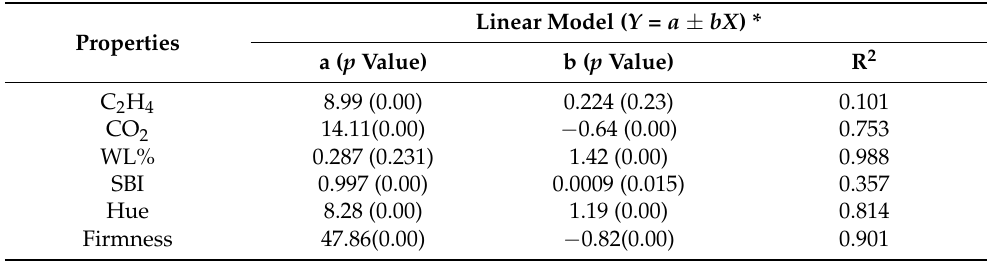
Table 6. Modeling of changes in the properties during the shelf life of the treated peach with GA/PVP–SA 2